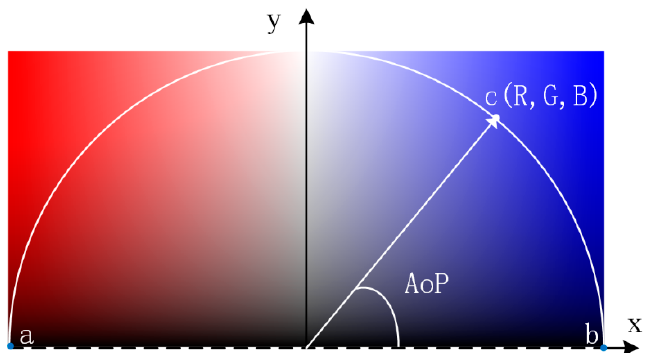
Figure 2. Relation diagram between AoP and I ( R , G , B ) according to our AoP data visualization method.